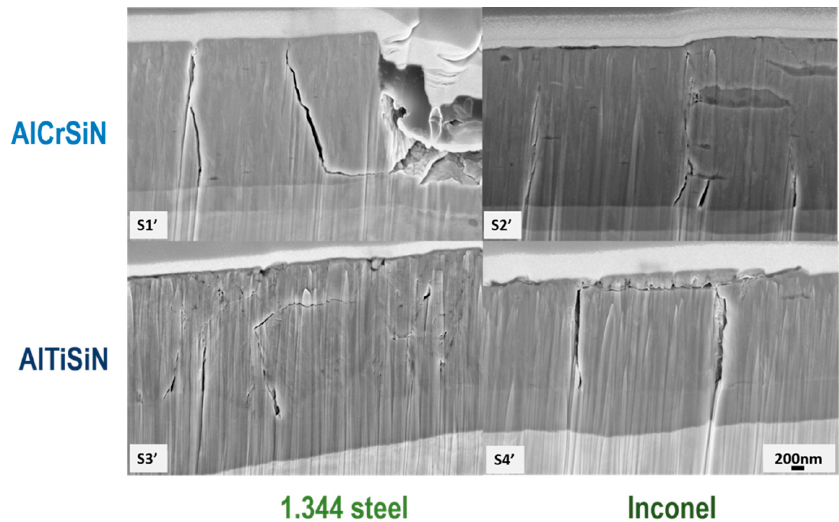
Figure 9. Cross-sectional SEM images at the same load (16 N) of scratch marked in Figures 5–8. Labels S1’ to S4’ are included for better refence in Table 7.